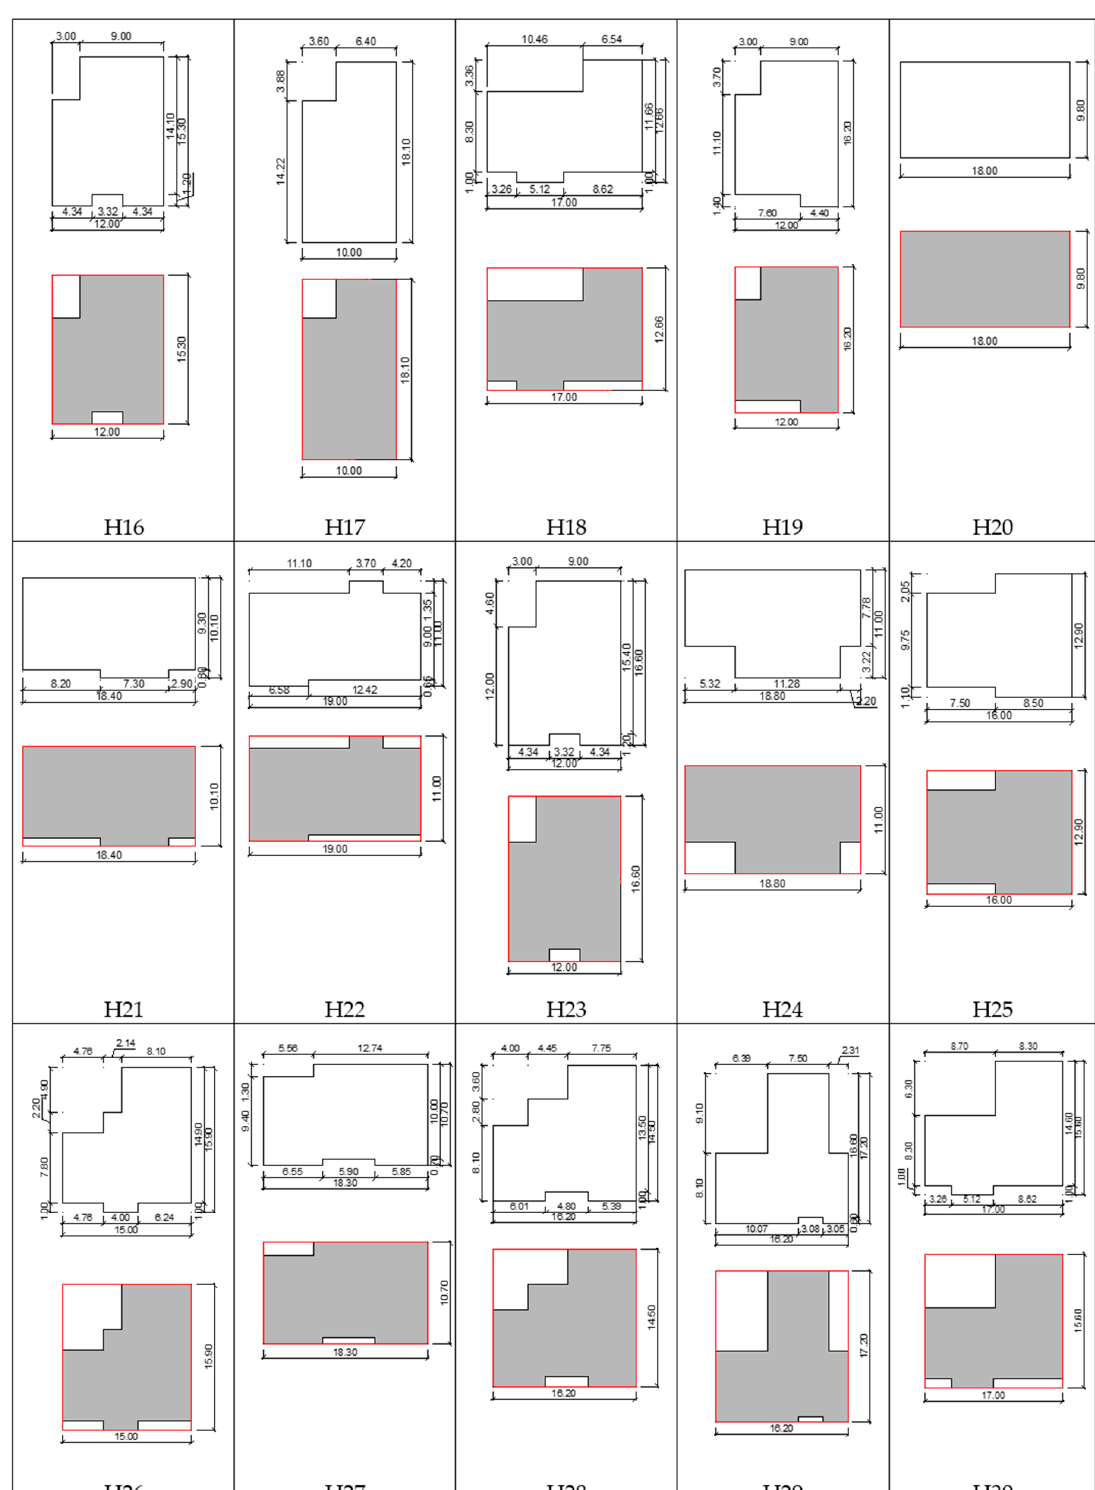
Figure A2. Building plans of the H16–H30 set and rectangles described on rectangular polygons of the plans of these buildings.